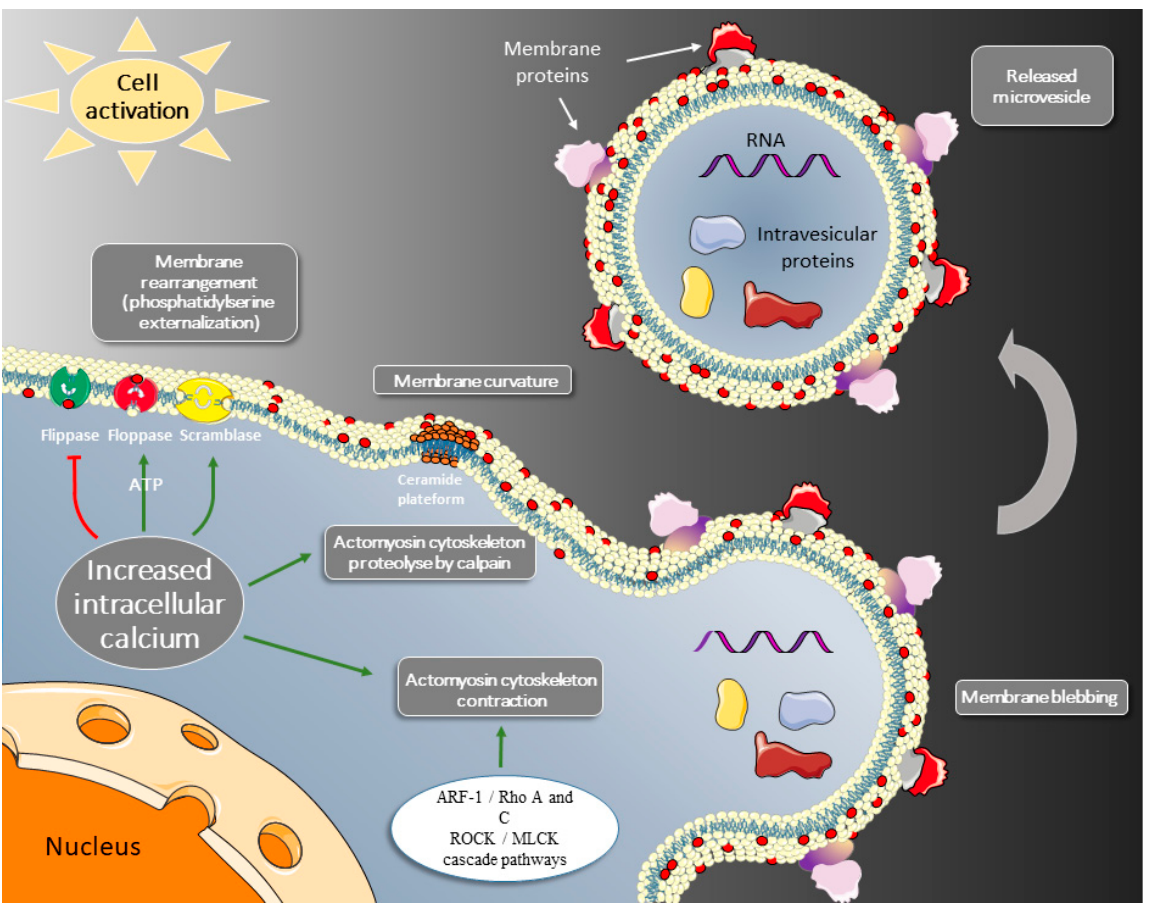
Figure 1. As a result of cell activation, the increase in intracellular calcium induces (i) exposure of phosphatidylserine at the outer leaflet of the membrane (red spot) through inhibition of flippase and scramblase-mediated transport, and ATP-dependent activation of floppase, (ii) membrane bending at the local ceramide-rich site, and (iii) contraction of the actomyosin cytoskeleton. Shed microvesicles constitute a catalytic surface for the assembly of coagulation factors and carry components of the parent cell. They distribute in the extracellular space and are thus able to induce, away from the parent cell, procoagulant (tissue factor), or fibrinolytic (plasminogen, uPA) activities. Some studies have shown that besides their well-known procoagulant activity, cell- Such membrane bags form extracellular vesicles of less than 1 μ m and above 100 nm, derived microvesicles carry plasminogen activators (either tPA or uPA) as well as a receptor for uPA (uPAR) and receptors for plasminogen [29,30]. The potential for plasminogen activation on microvesicles is of particular interest as they may convey this activity and plasmin to distant sites. Microvesicles may thereby induce extracellular proteolysis and fibrinolysis, intermediary mechanisms in angiogenesis and thrombus